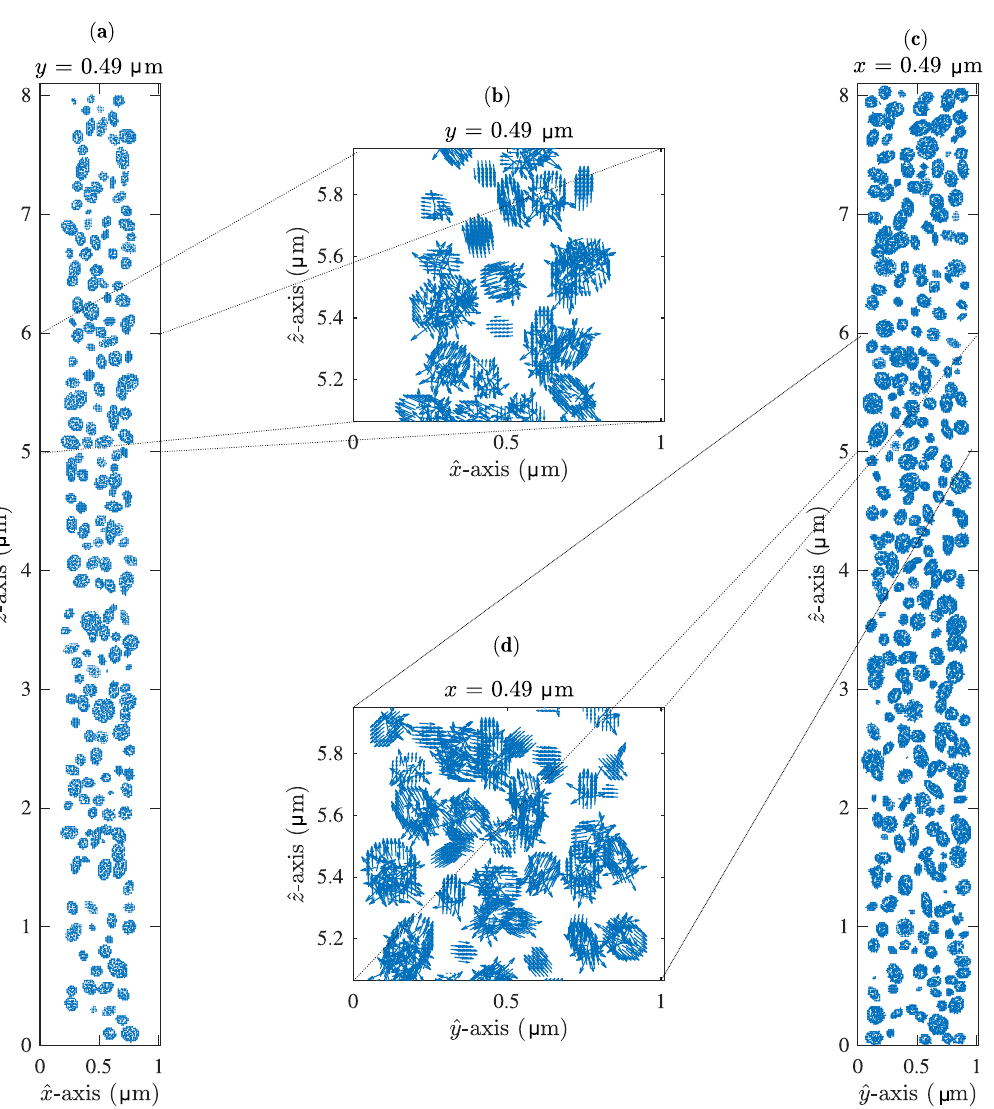
Figure 2. Representation of the initial random LC director through some slices of the H-PDCLC sample generated, here the anchoring strength is W 0 = 10 − 5 J/m 2 and Φ = 0 V: ( a ) xz plane. ( b ) Zoom in of a region in the xz plane. ( c ) yz plane. ( d ) Zoom in of a region in the yz